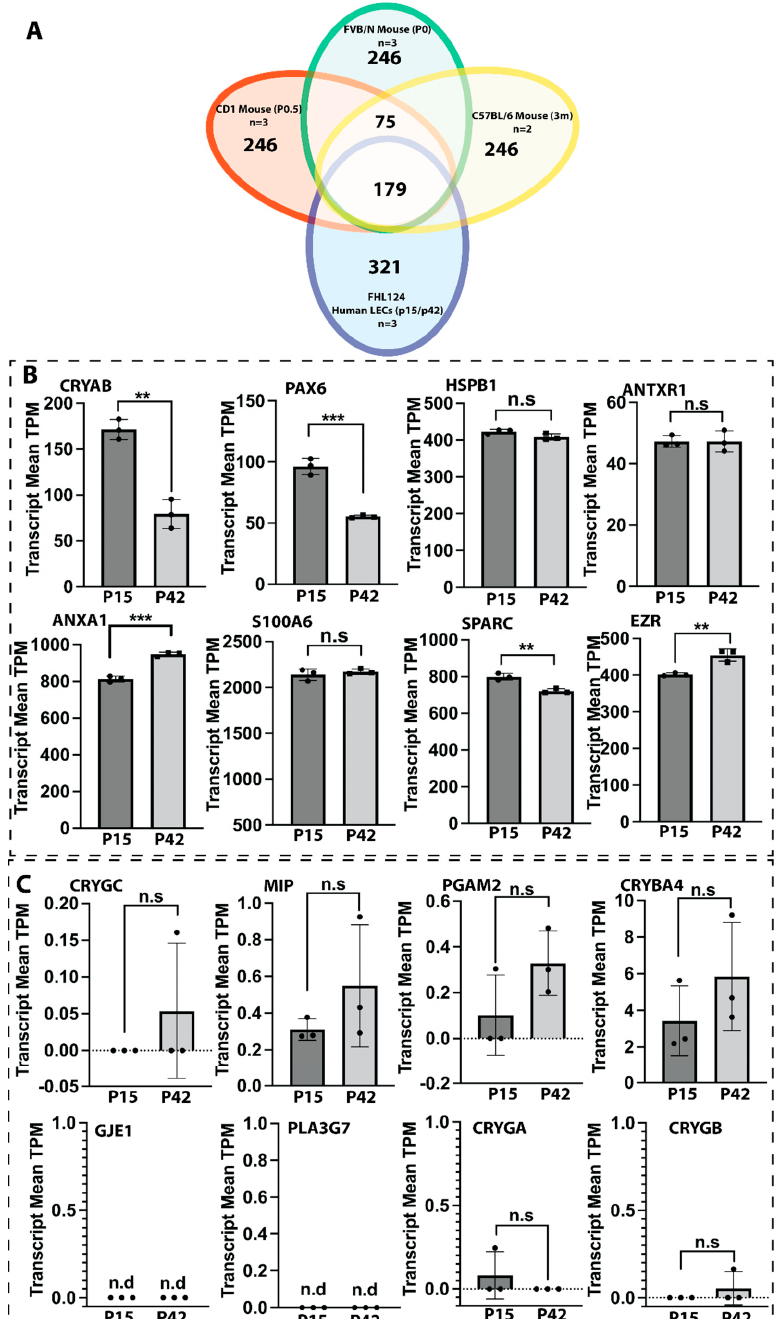
Figure 1. Normalized pro-LEC and pro-fiber cell gene expression in P15 and P42 FHL124 cells. ( A ) Shared and distinct top 500 most expressed genes between mouse lens epithelium and the human FHL124 LECs. ( B ) Pro-LEC gene transcript means count measured as transcript per million (TPM). ( C ) Pro-fiber gene transcript means count measured as transcript per million (TPM). Results are expressed as mean ± SD and were analyzed using Student’s t-test. Only p < 0.05 is considered significant. * < 0.05, ** < 0.01, *** < 0.001, **** < 0.0001; n.s, not significant; n.d, not